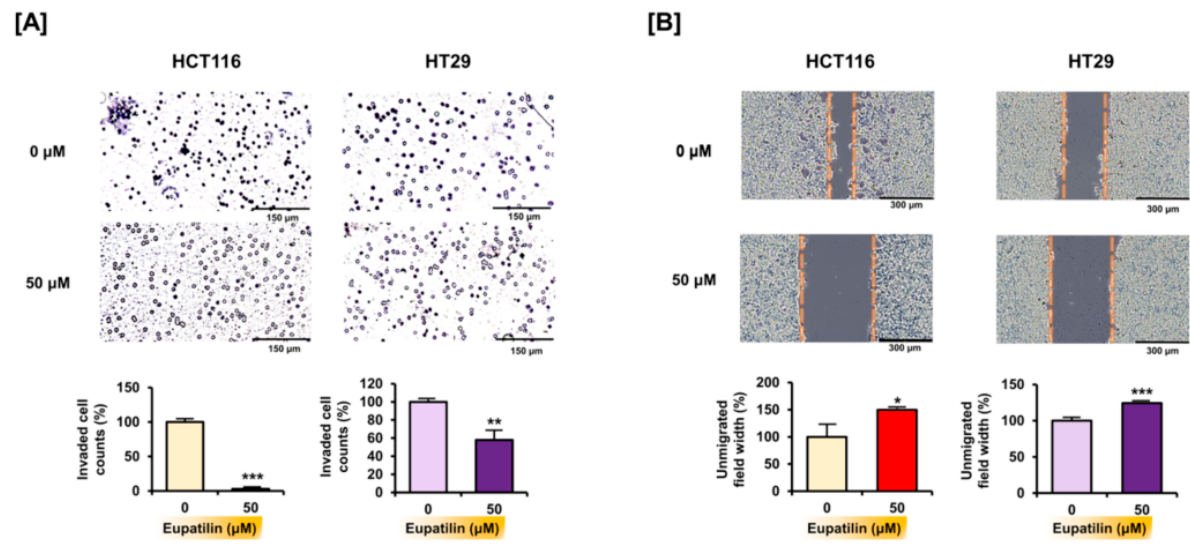
Figure 6. Eupatilin inhibits invasion and migration in colon cancer cells. ( A ) Invasive capacities were measured using the Transwell migration assay. Eupatilin significantly decreased invasion. ( B ) Migration of HCT116 and HT29 cells in response to eupatilin calculated based on gap distance. Asterisks indicate a significant change after eupatilin treatment (*** p < 0.001, ** p < 0.01, and * p < 0.05).